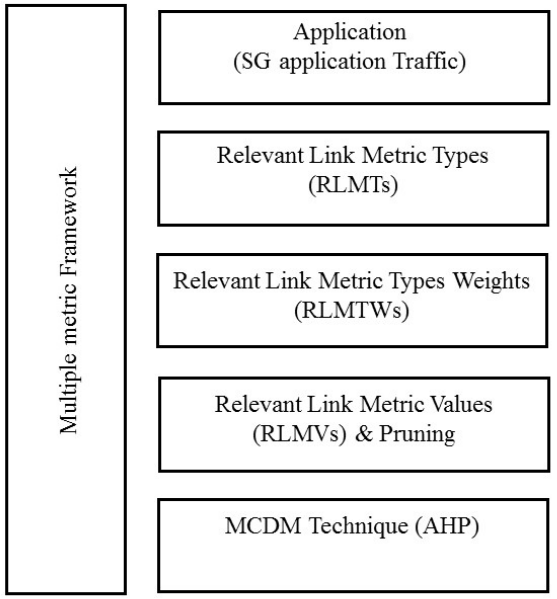
Figure 1. Components of the multiple metrics